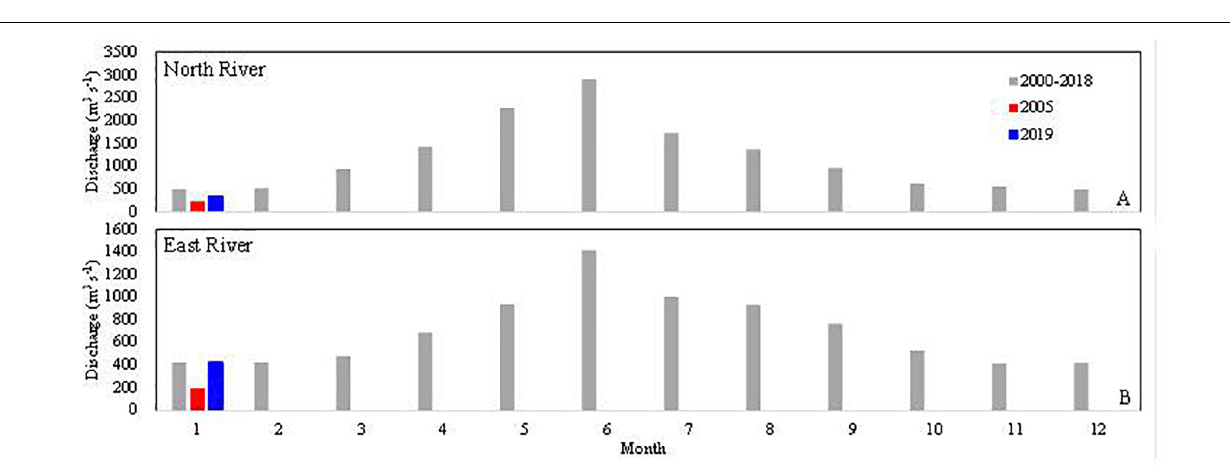
FIGURE 2 | Freshwater discharge downstream of the North River (Shijiao gauge station) and East River (Boluo gauge station). Label of panel B is the same with panel A . Data are from the Annual Hydrological Report (2000–2018), Hydrology Bureau, Ministry of Water Resources of the China